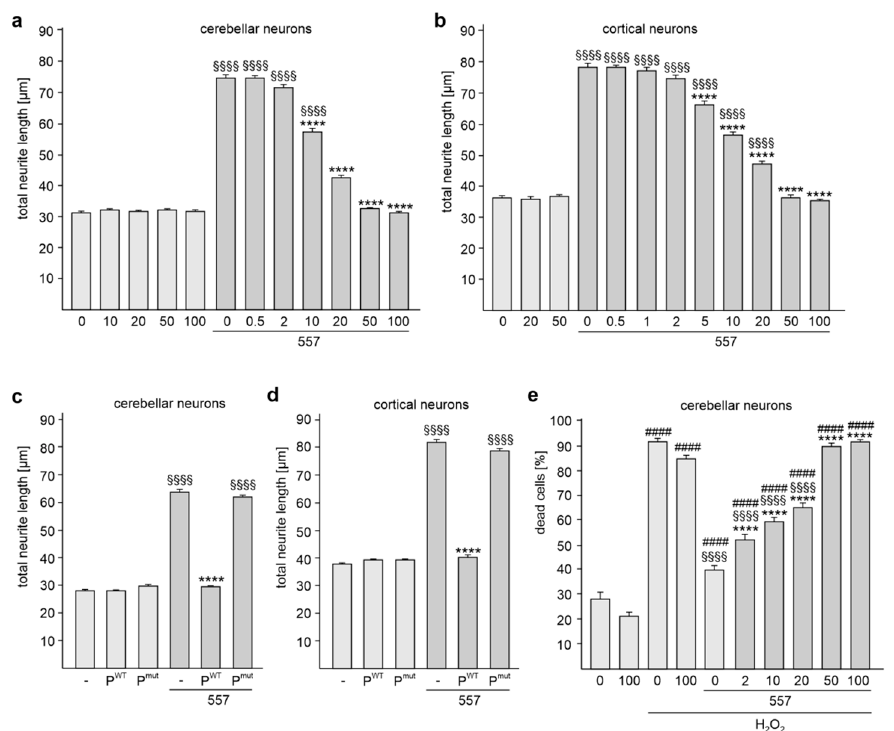
Figure 4. The KDET-mediated interaction of L1 with its binding partners is essential for L1-dependent neurite outgrowth and neuronal cell survival. Cerebellar ( a , c ) and cortical ( b , d ) neu- rons were treated with 0, 0.5, 1, 2, 5, 10, 20, 50, or 100 µg/mL tat-KDET peptide ( a , b ), with 0 or 50 µg/mL tat-KDET peptide (P WT ) or with 0 or 50 µg/mL tat-QNQS peptide (P mut ) ( c , d ). Neurons were then treated without or with antibody 557. Mean values + SEM from three independent experiments are shown for total neurite lengths (**** p < 0.0001 relative to stimulated neurons not treated with tat-KDET peptide, §§§§ p < 0.0001 relative to non-stimulated neurons not treated with tat-KDET pep- tide or tat-QNQS peptide; one-way ANOVA with Dunn’s multiple comparison test). ( e ) Cerebellar neurons were first treated with 0, 2, 10, 20, 50, or 100 µg/mL tat-KDET peptide and then treated without or with antibody 557 in the absence or presence of H 2 O 2 . Mean values + SEM from three in- dependent experiments are shown for the relative numbers of dead cells (**** p < 0.0001 relative to stimulated neurons not treated with tat-KDET peptide in the presence of H 2 O 2 , §§§§ p < 0.0001 rela- tive to non-stimulated neurons not treated with tat-KDET peptide in the presence of H 2 O 2 , #### p < 0.0001 relative to unstimulated neurons not treated with tat-KDET peptide in the absence of H 2 O 2 ; one-way ANOVA with Dunn´s multiple comparison